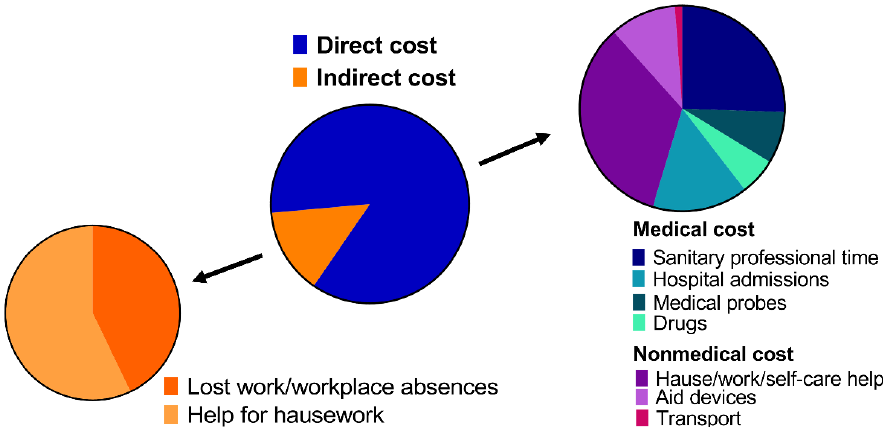
Figure 1. The economic cost of knee and hip OA in Spain. Data from [14]. Due to the increase in cases that not only worsen the quality of life of those affected patients, but also have a great economic cost, improvement of the treatment of this disease is a